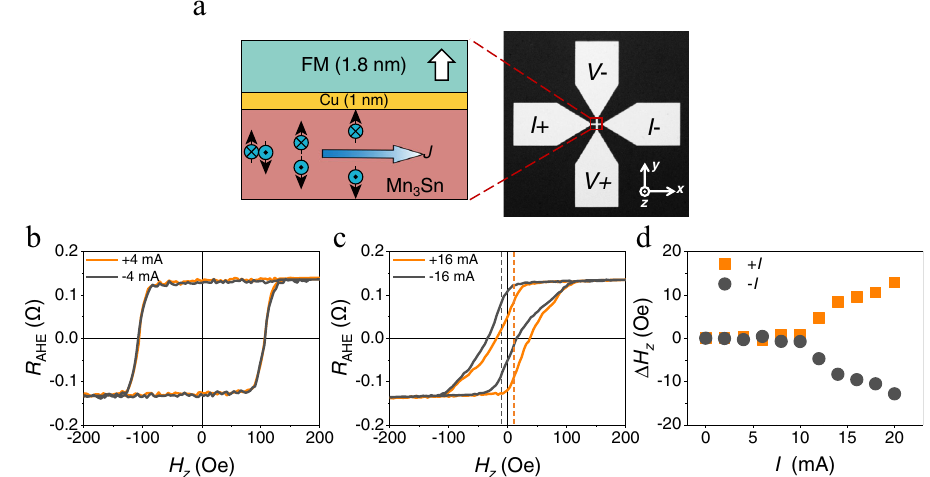
Fig. 2 | Z -polarized spin current generated by Mn 3 Sn thin fi lm. a The schematic of Mn 3 Sn (7)/Cu (1)/FM (1.8) stack (left) and optical image of the device using for electrical transport measurements (right). The spins with both ± y and ± z polar- izations generated by bottom Mn 3 Sn thin fi lm will act on the ferromagnetic layer